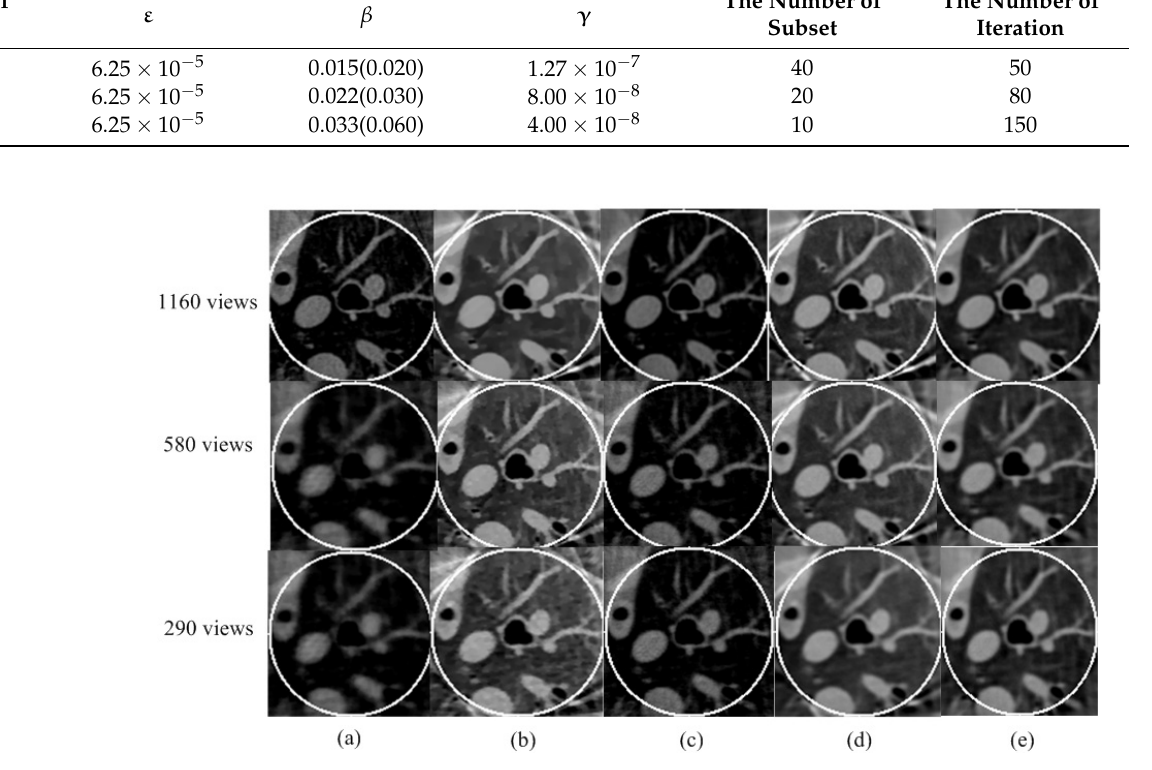
Figure 6. Reconstructed ROIs from normal-dose real sheep data using five different methods: ( a ) SIRTV + BOS; ( b ) SIRTV + OS; ( c ) SIRDL + BOS; ( d ) SIRDL + OS; ( e ) SIRDL + HL. The display window is [ − 700 800]HU.